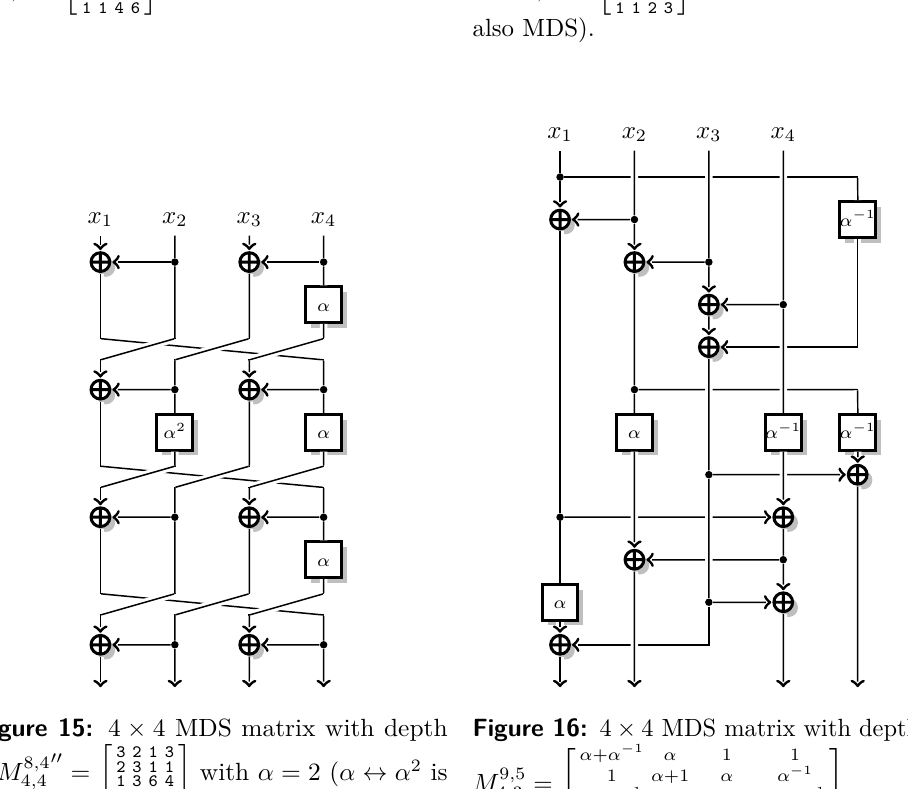
Figure 13: 4 × 4 MDS matrix with depth 4: (cid:20) 5 7 1 3 4 6 1 1 = M 8 , 4 4 , 4 1 3 5 7